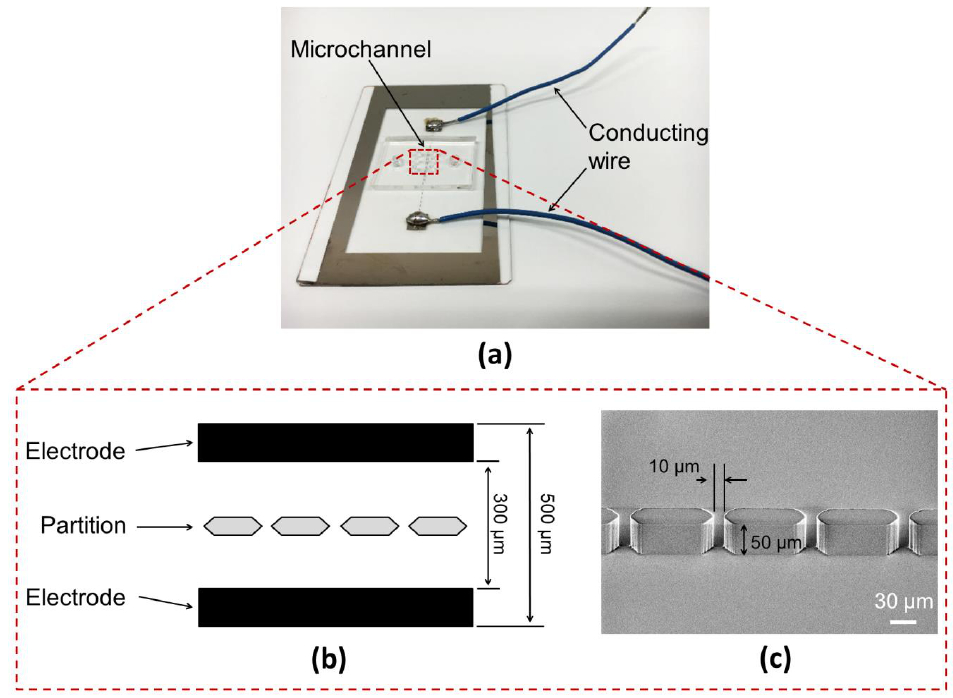
Figure 2. ( a ) Photo of the fabricated microfluidic device; ( b ) schematic illustration of the partitions and the electrodes; and ( c ) Scanning electron microscope (SEM) image of the partitions.